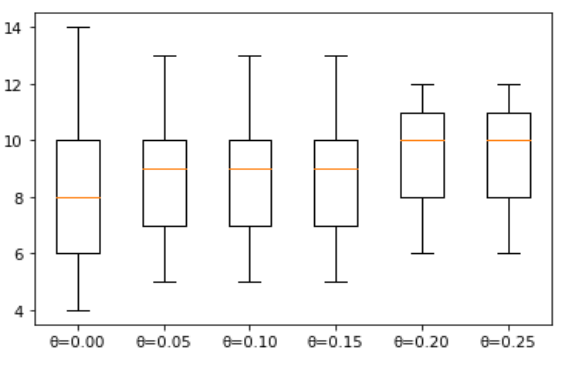
Figure 1. Box plot of the results for the Newsvendor Problem with Uniform(0, 10) and R = 100.